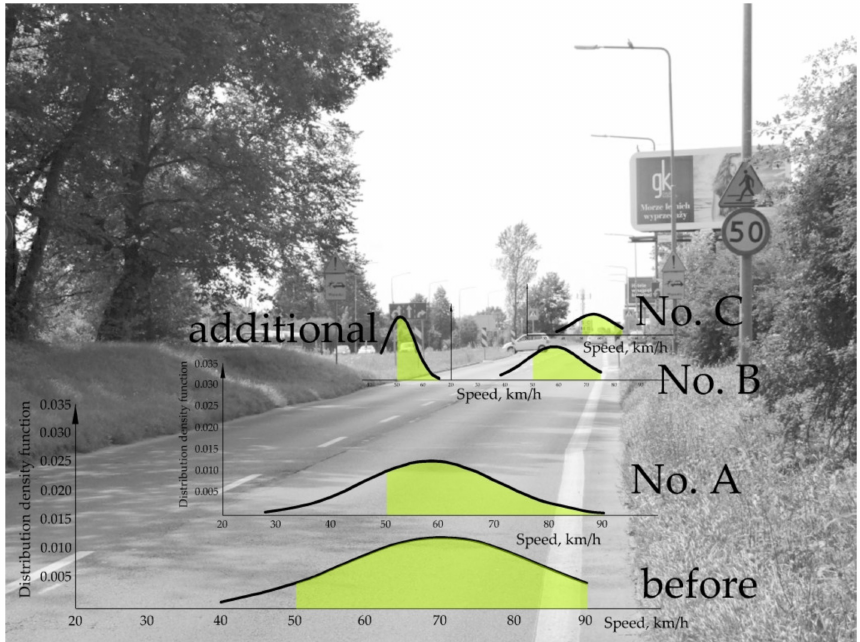
Figure 6. Gaussian curve of speed distribution on the test sections on the westbound carriageway (ca. 600 m approach along a straight section).